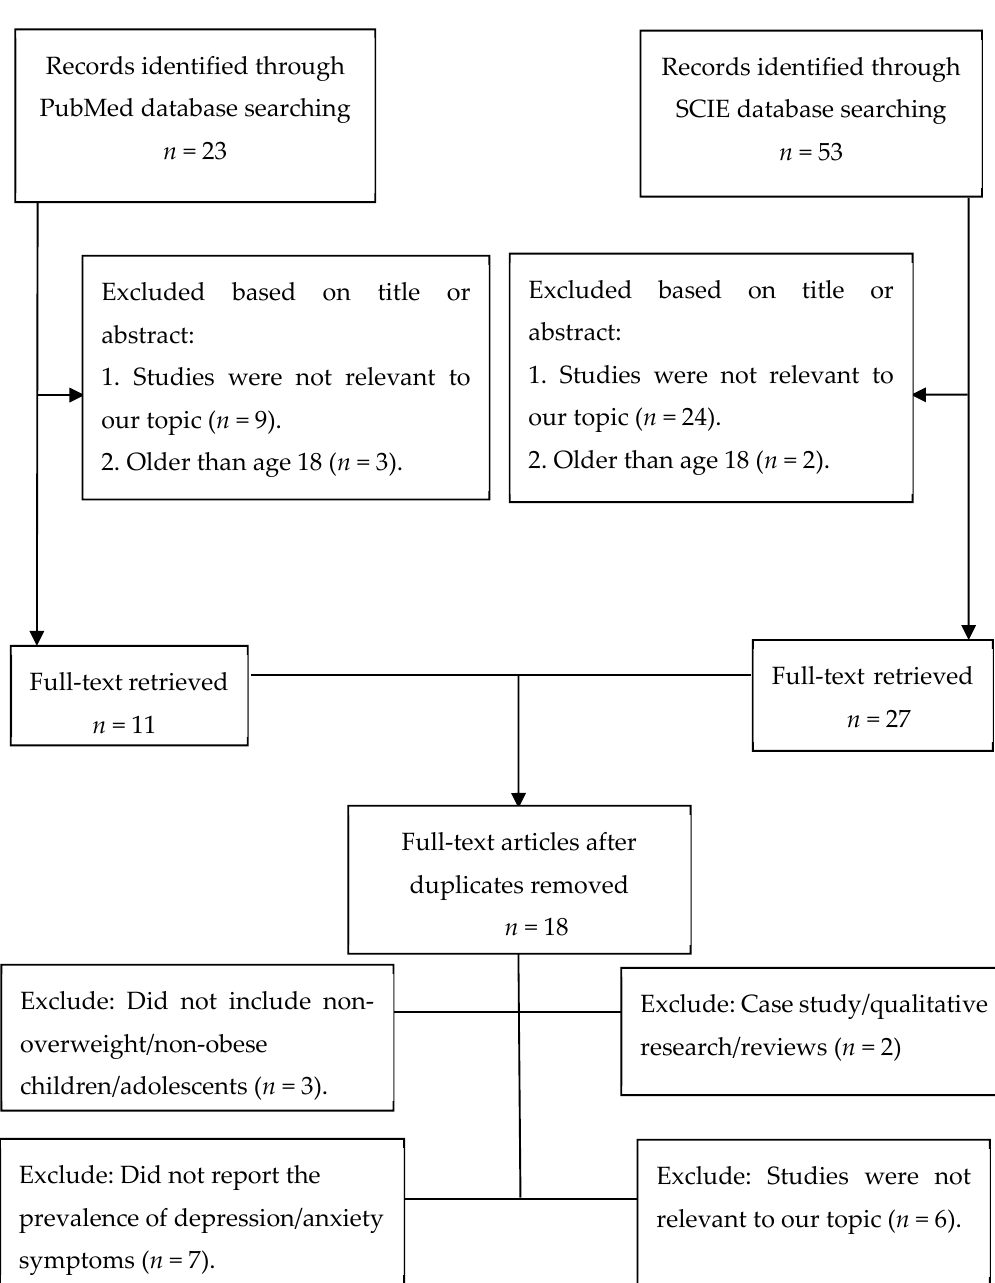
Figure 2. The selection process of the study (international databases).